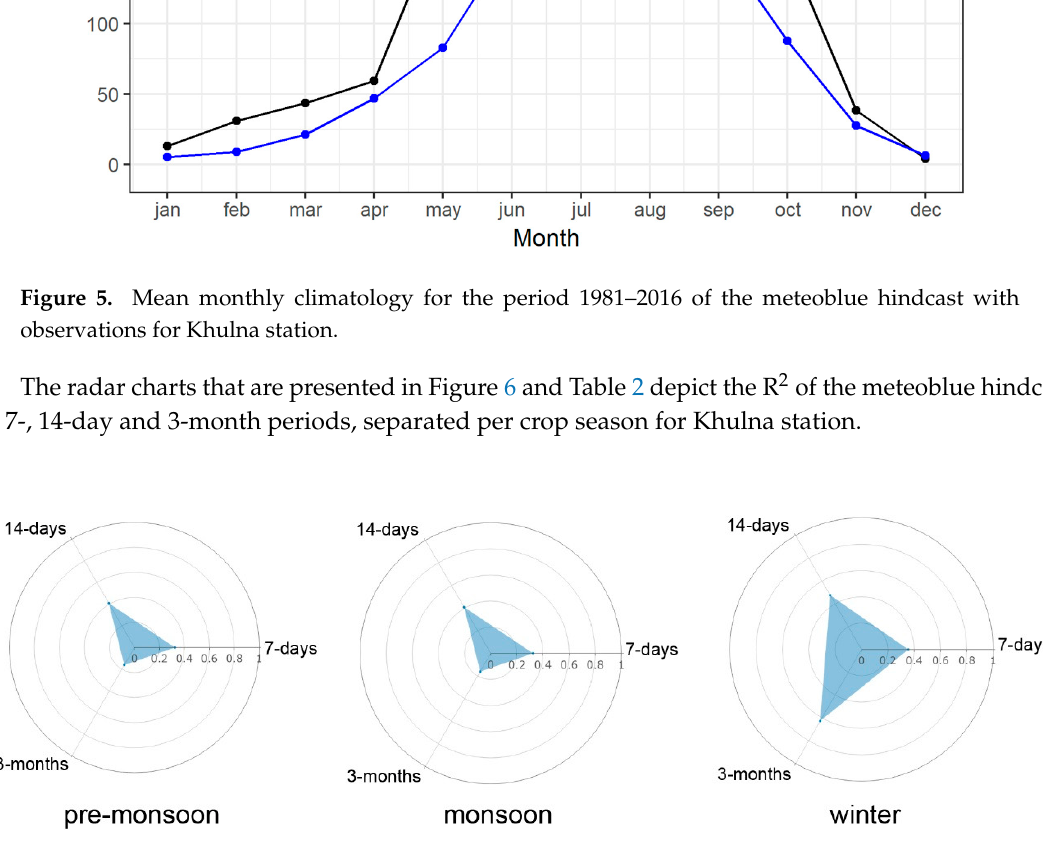
Figure 6. Radar charts of correlation for 7-, 14-day and 3-month meteoblue hindcasts with the observations for Khulna station.